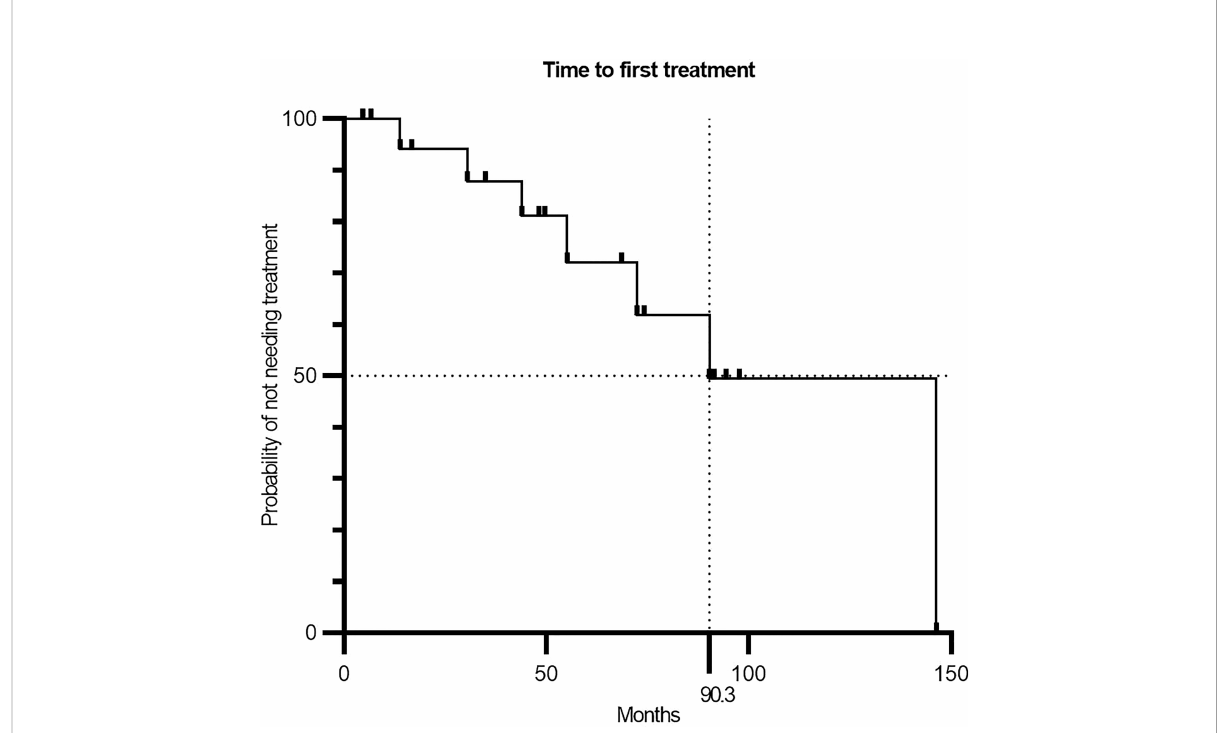
FIGURE 3 Kaplan – Meier curve showing the time between CLL diagnosis and initiation of fi rst treatment (n = 19). CLL, chronic lymphocytic